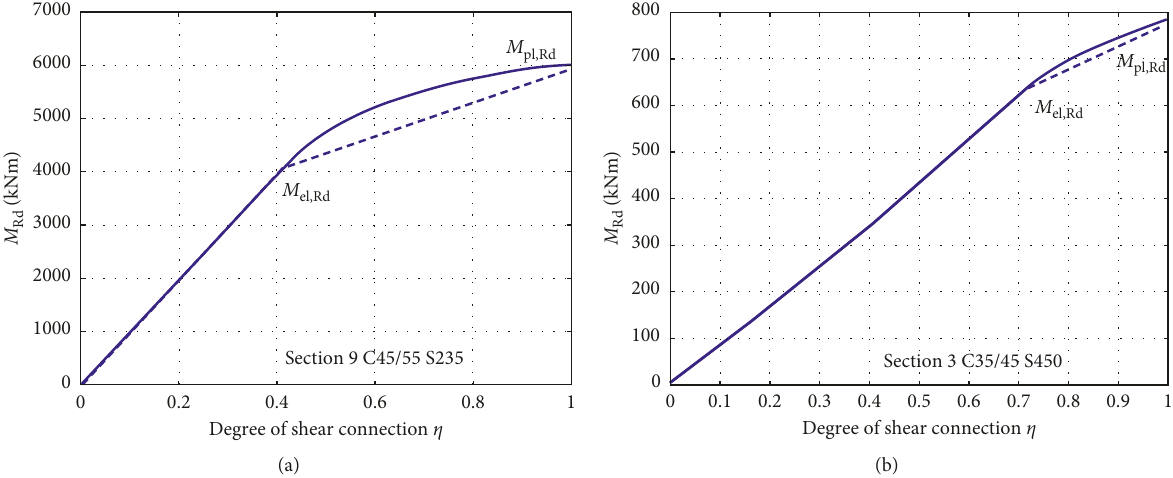
Figure 11: Nonlinear and linear bending moment curve (propped constructional method). (a) Maximal difference (Section 9 C45/55 S235) and (b) minimal difference (Section 3 C35/45 S450).